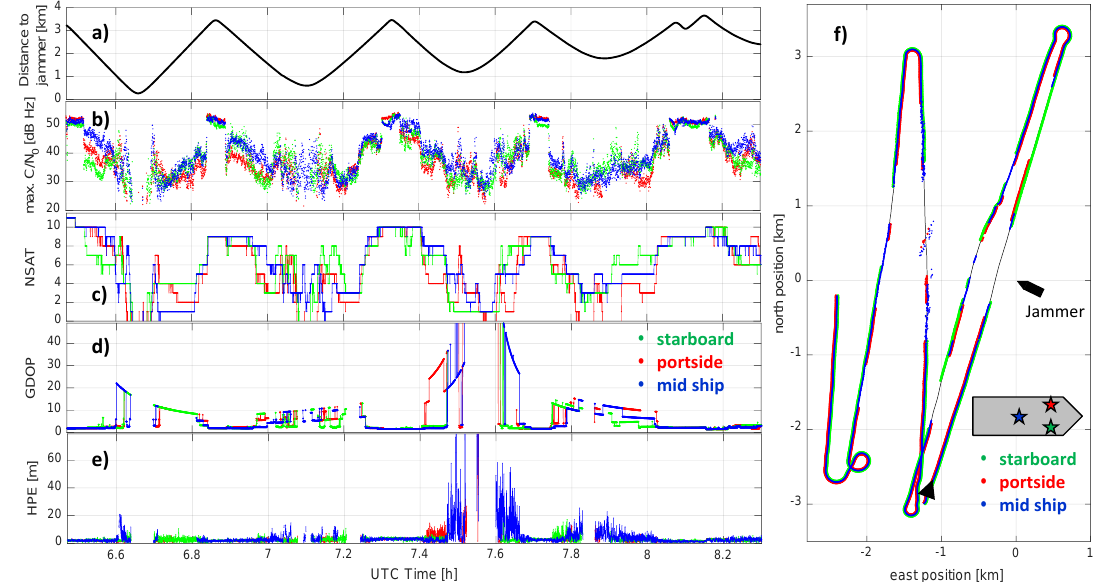
Figure 9. An overview of GPS positioning results of the three antennas/receivers onboard the vessel BALTIC TAUCHER II during the measurement campaign in the Baltic Sea, 2 October 2015 at